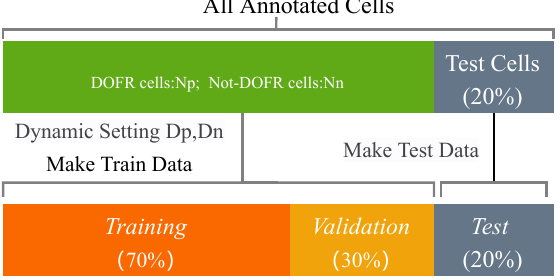
Figure 6. The apportion of cells used for training and